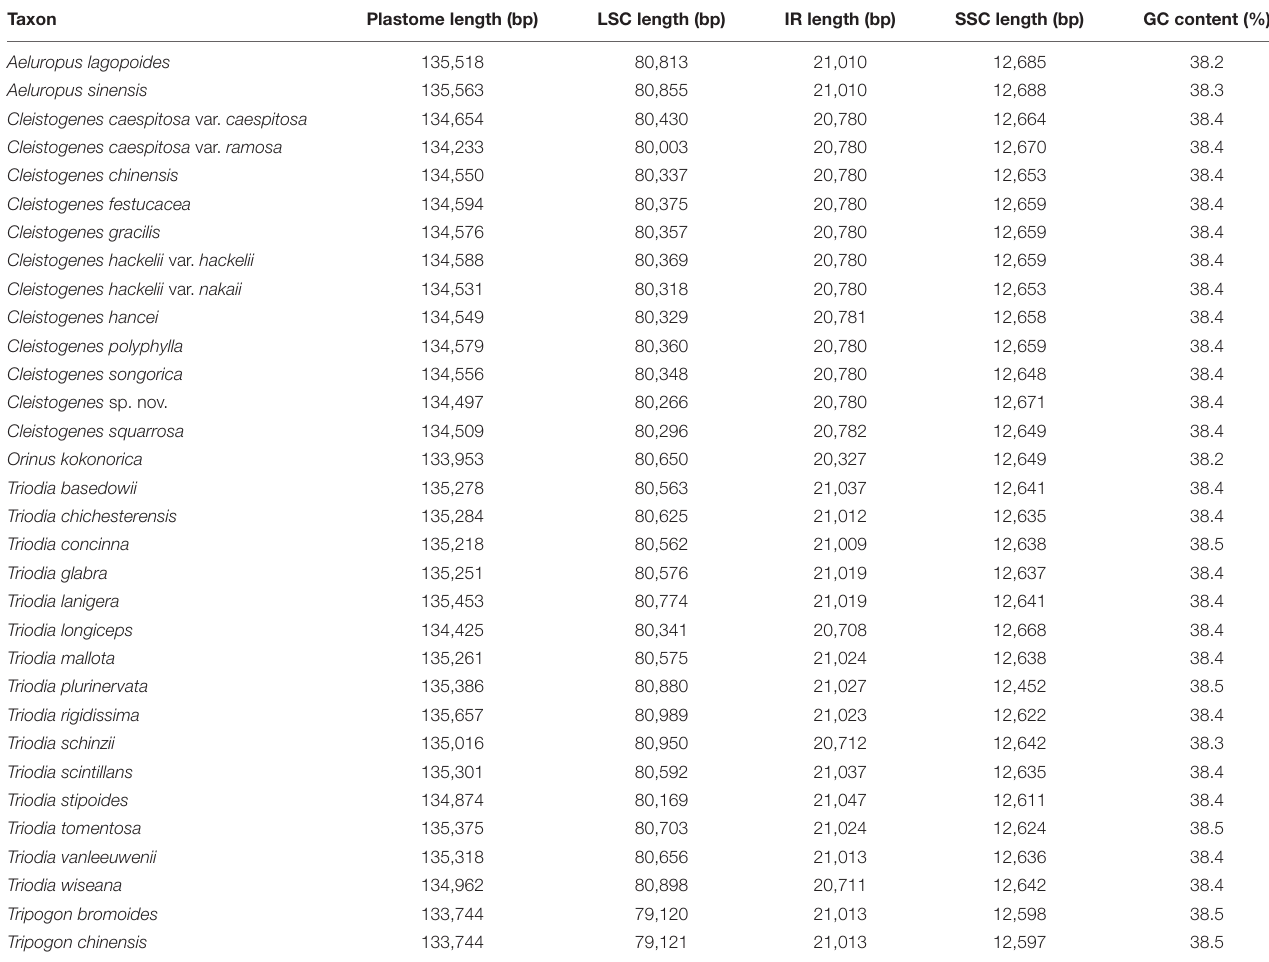
TABLE 2 | Summary of major characteristics of the 32